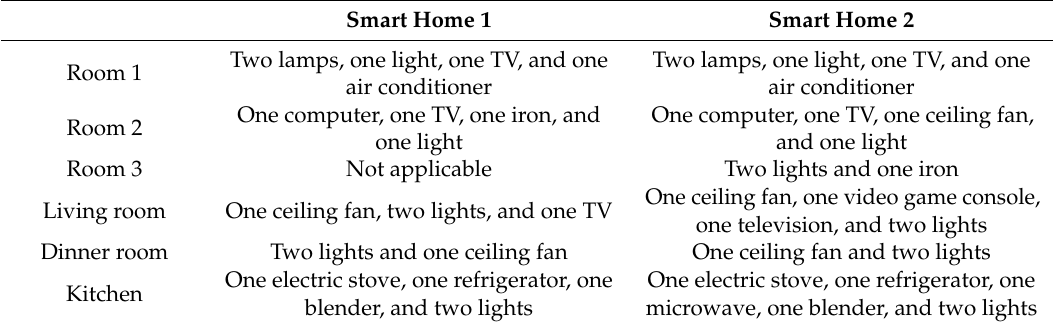
Table 1. House design and